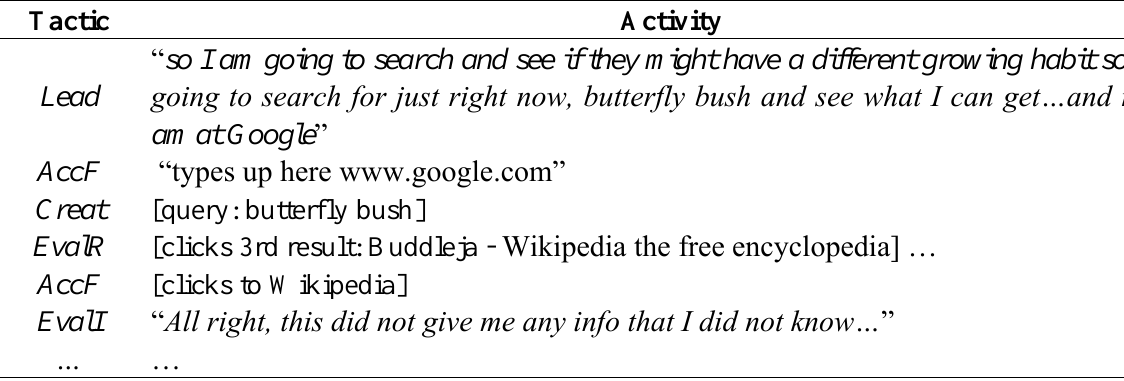
Table 11. Query initiation